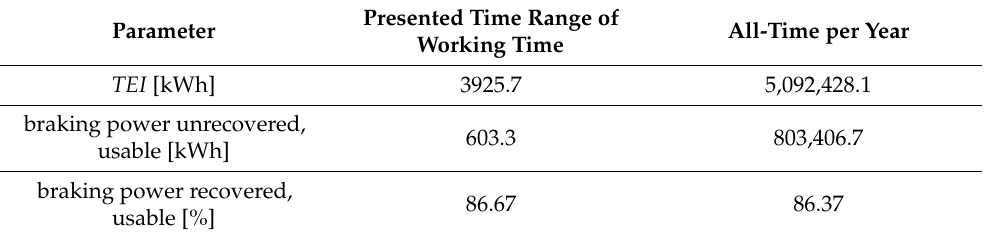
Table 4. Characteristics of variant before timetable reconfiguration.